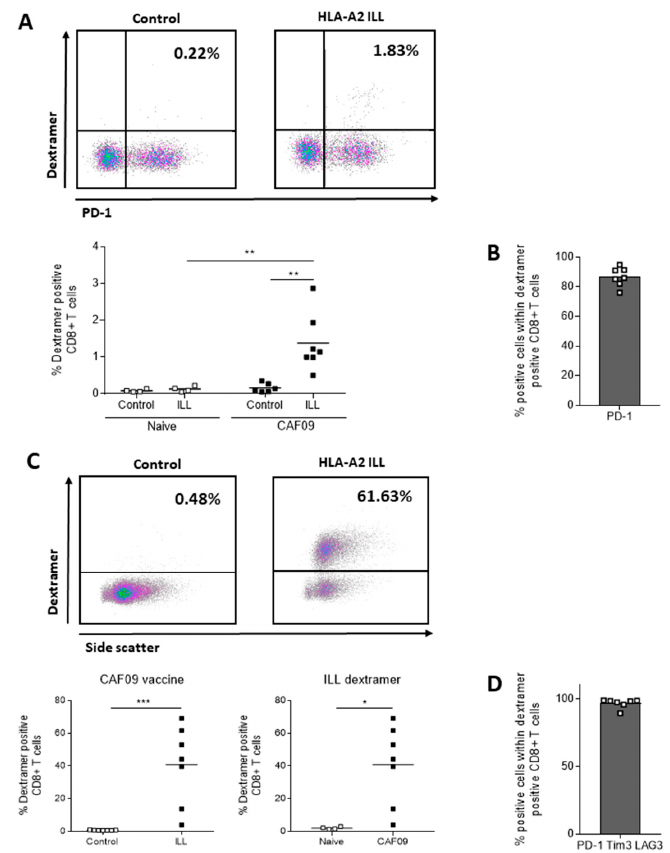
Figure 6. Vaccine-induced ILL-specific CD8 + T cells, as detected using Dextramer™ staining, almost exclusively express PD-1. HHDII/DR1 mice were immunized on days 1, 15, and 29 with either the CpG or the CAF ® 09-based mutated hPAP 42 mer vaccine. Seven days after the final immunization, splenocytes were isolated from spleens. Splenocytes were then incubated with a murine FcR block, stained with surface mAbs for flow cytometry analysis indicating ( A ) proportion of CD8 + T cells and ( B ) expression of inhibitory receptors, on freshly isolated splenocytes, or incubated with ILL 9 mer peptide for 6 days and stained for flow cytometry analysis indicating ( C ) proportion of CD8 + T cells and ( D ) expression of inhibitory receptors. CAF ® 09-based vaccine induced ILL-specific CD8 + T cells ( A ) expressing PD-1 ( B ), which were expanded with in vitro peptide stimulation ( C ) and co- expressed PD-1, Tim-3, and LAG-3 ( D ). The p -values were annotated as follows: * p < 0.05, ** p < 0.01, *** p < 0.001.